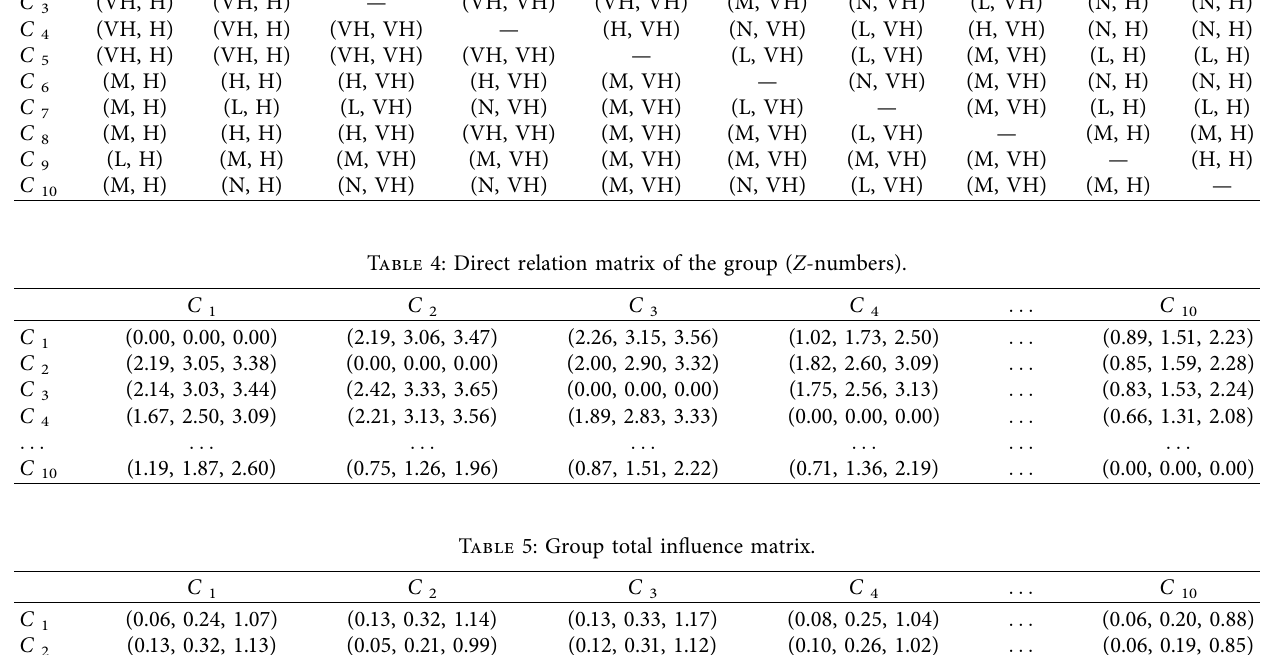
Table 3: Direct relation matrix of expert 1 (linguistic variables).